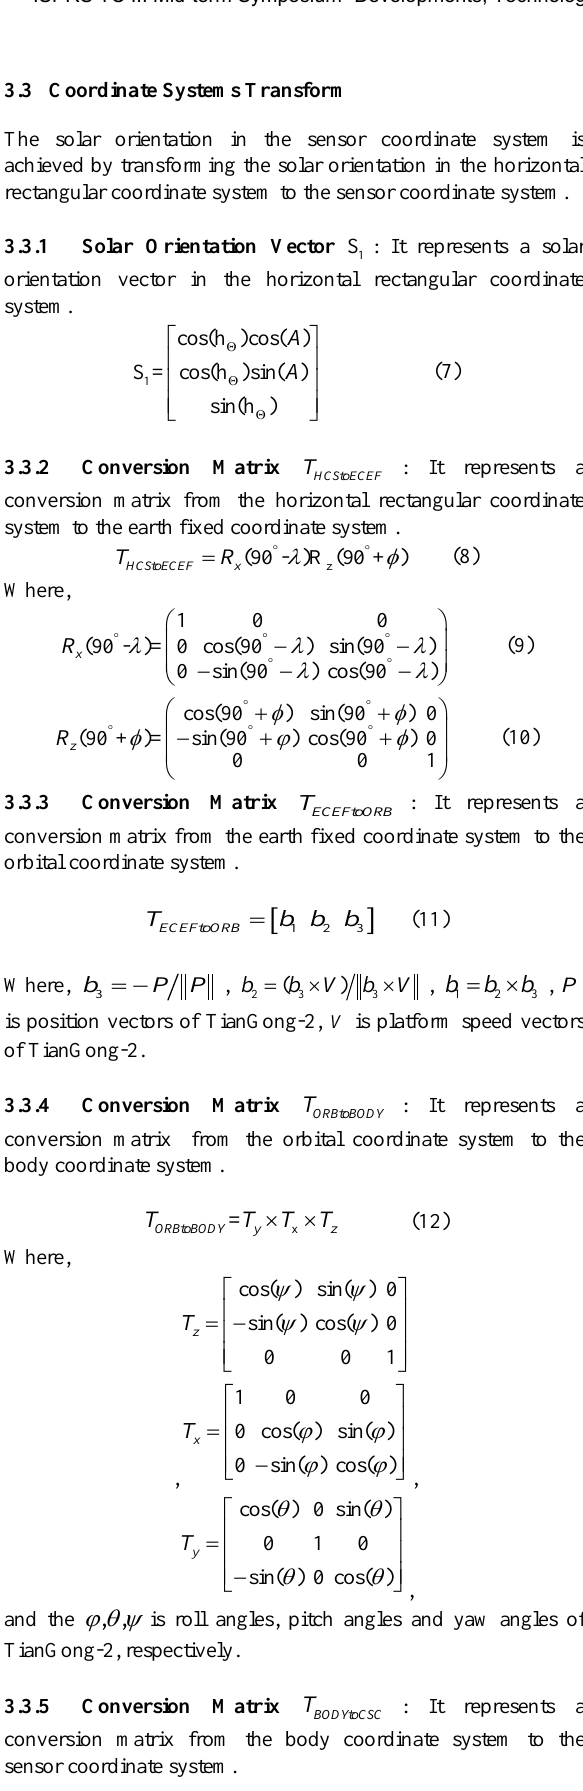
curve is the STK simulation